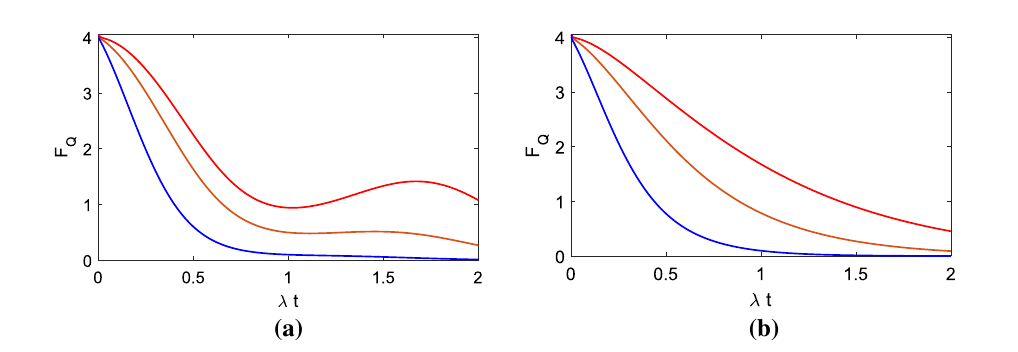
1 (cid:31) = 3 (cid:31) = 1 20 (red), γ/ 4 (brown), γ/ 4 (blue). ( a ) D /